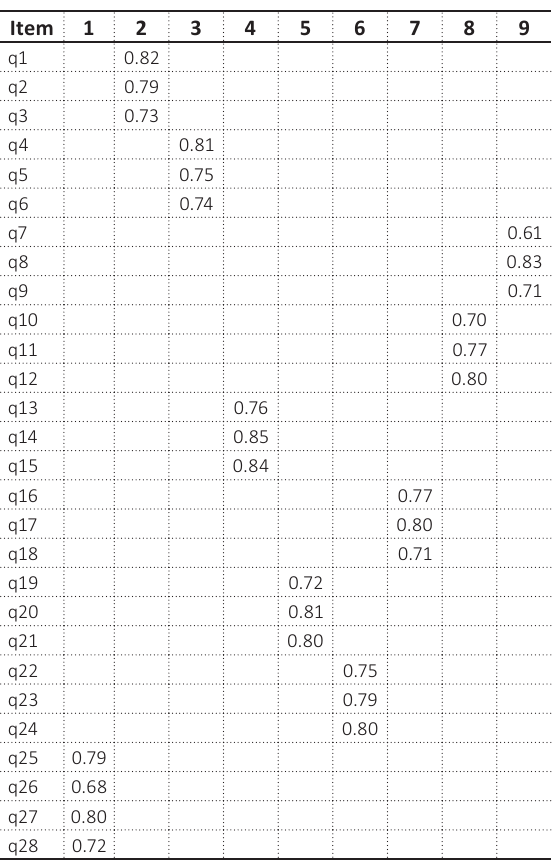
Table 3. Rotated component matrix (Component F1)